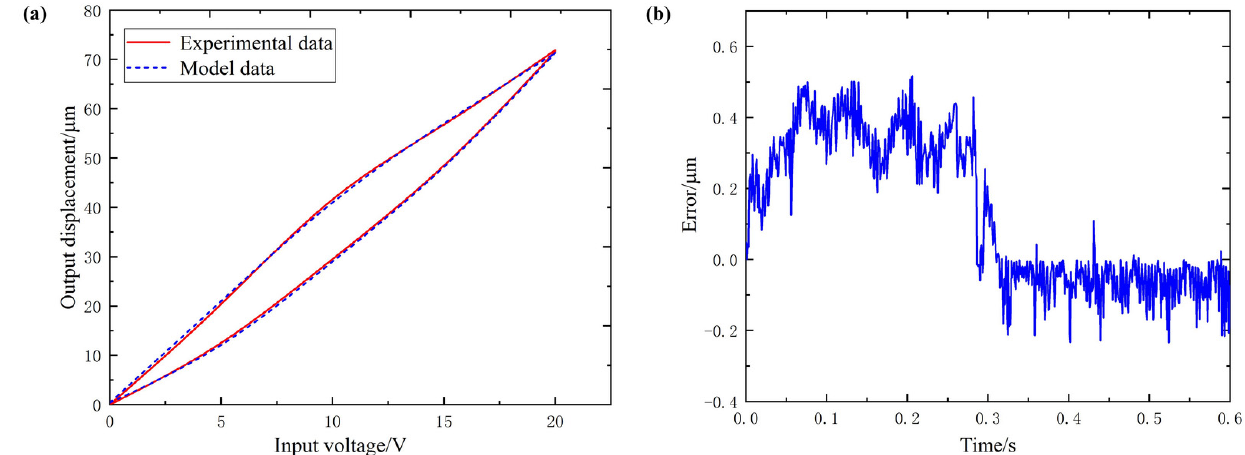
Table 3. Modeling error and accuracy of each axis of 3D-EVC system.